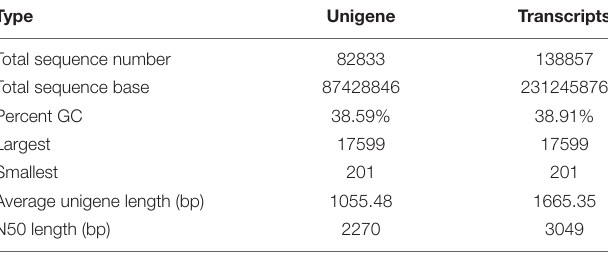
TABLE 1 | Summary of Illumina transcriptome sequencing.